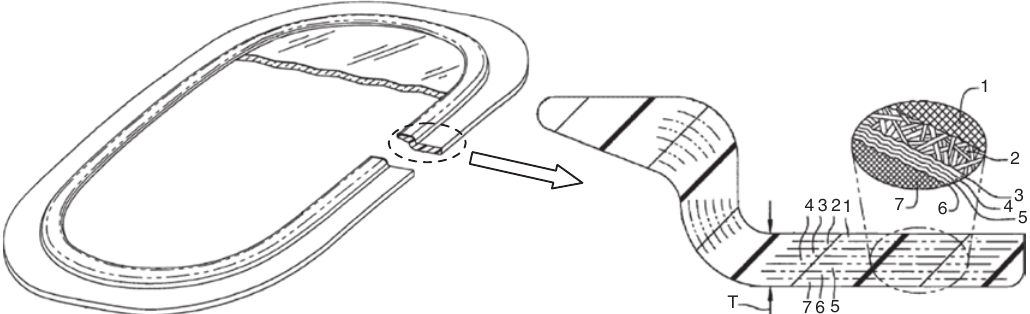
Figure 1: Composite window frame.